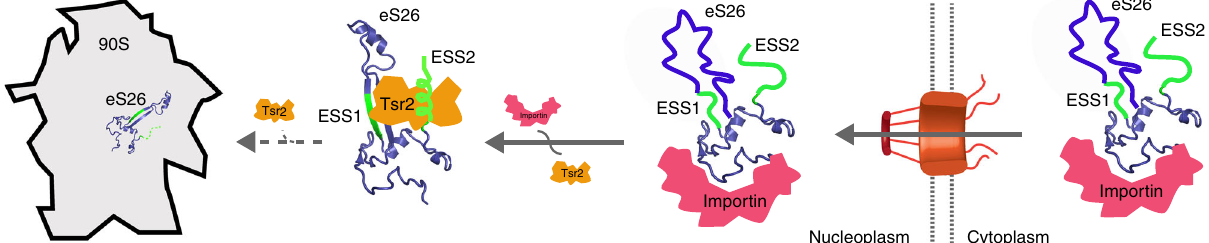
Fig. 7 Model for the transport of eS26 to the 90S pre-ribosome. Newly synthesized and unfolded eS26 is transported from the cytoplasm into the nucleus by importins. In the nucleus, Tsr2 dissociates eS26 from importins in a RanGTP-independent manner through eukaryotic-speci fi c segments (ESSs) in eS26. Tsr2 then sequesters the released eS26 enabling safe transfer to the 90S